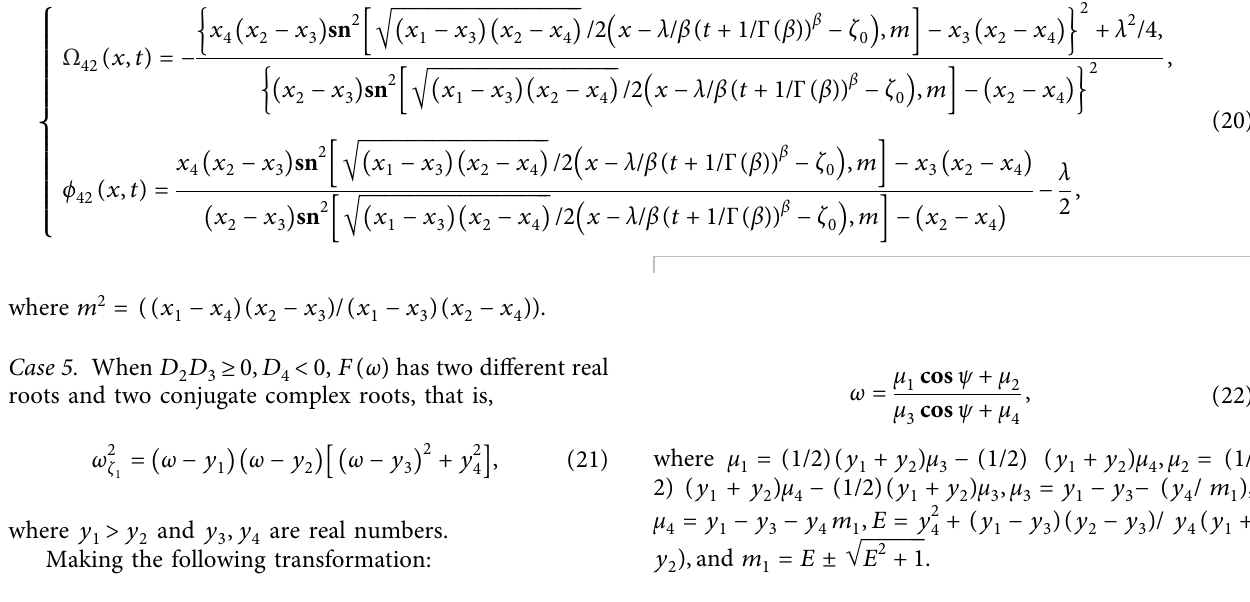
( x, t ) in equation (15) at a 2